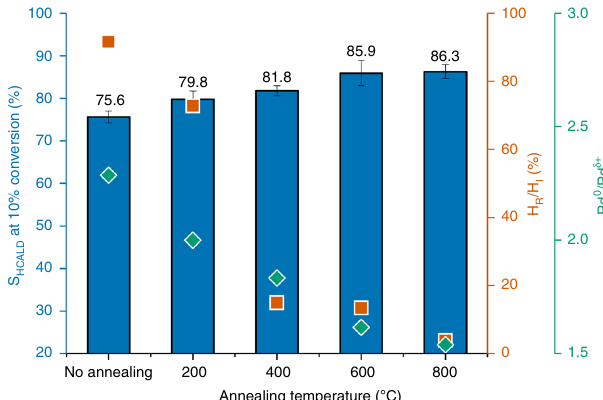
Fig. 3 Effect of carbon supports on catalytic performance. The bar graph